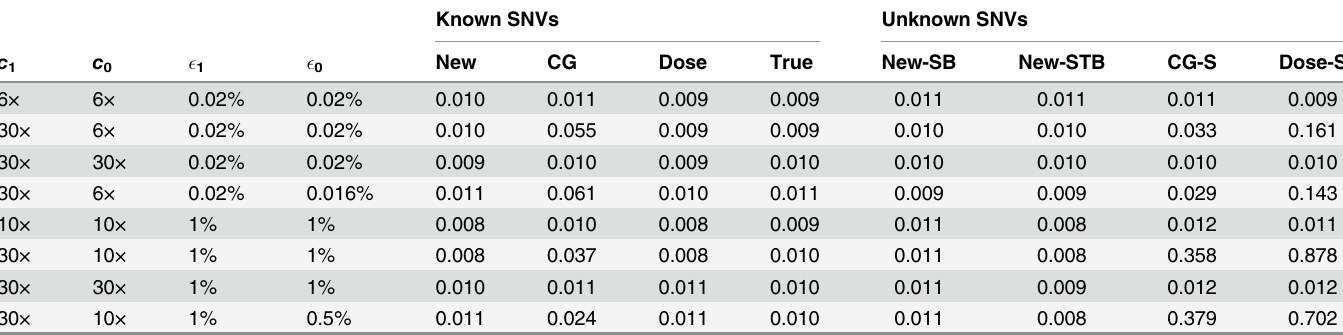
Table 1. Type I error of the weighted burden test at the nominal significance level of 0.01.